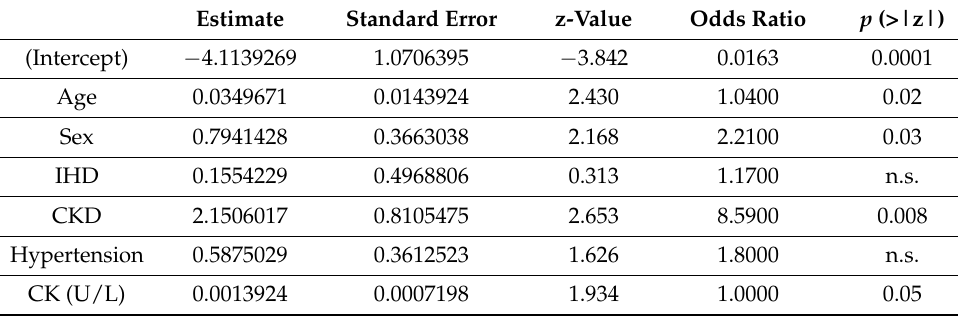
Table 1. Multiple logistic